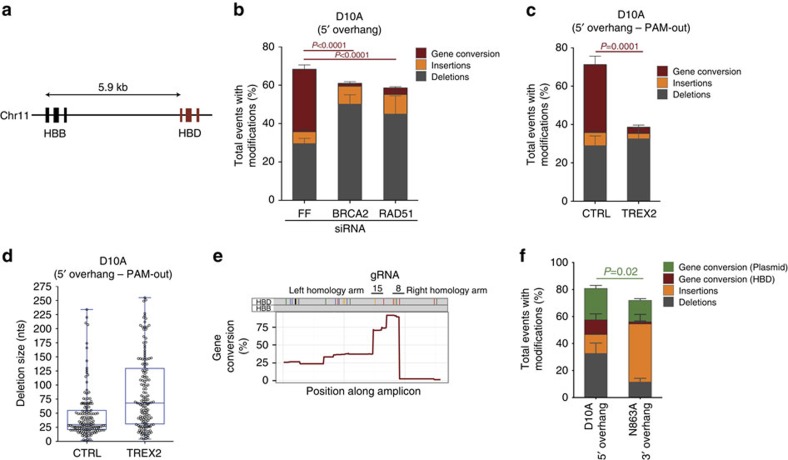
Characterization of repair outcomes of lesions introduced with the D10A Cas9 variant using gRNA pair 8/15.(a) Schematic illustration of the HBB and HBD loci on chromosome 11. (b) U2OS treated with an siRNA against firefly luciferase (control, labelled as FF), BRCA2 or RAD51 in addition to the D10A Cas9 and gRNAs 8/15. The overall modification frequency at the HBB locus resolved for deletions, insertions and gene conversion (GC) was determined by Sanger sequencing. P values (GC) were calculated using the two-tailed Student's t-test. Four independent experiments. Data are represented as mean±s.e.m. Total number of sequences analysed: 476, 407, 389 for siFF, siBRCA2 and siRAD51-treated cells. (c) The overall modification frequency resolved for deletions, insertions and GC scored by Sanger sequencing of the amplified HBB locus in U2OS cells expressing the D10A Cas9 and gRNAs 8/15 in the presence (TREX2) or absence (CTRL) of TREX2. Due to limiting amplicon size primer pairs underestimate deletion frequency. P value (GC) was calculated using the two-tailed Student's t-test. Five independent experiments. Total number of sequences: 578 for CTRL and 529 for TREX2. Data are represented as mean±s.e.m. (d) Scatter dot plot overlaid with a box and whisker plot representing the deletions size from Sanger sequences of U2SOS cells expressing D10A Cas9 with gRNAs 8/15 in the presence (TREX2) or absence (CTRL) of TREX2. Each individual dot represents one Sanger sequence with a deletion. Due to limiting amplicon size primer pairs underestimate deletion frequency. The line within the box depicts the median, with the box extending from the 25th to the 75th percentiles. The whiskers depict the minimum and maximum values of the data set. Five independent experiments, total number of sequences: 147 for CTRL and 149 for TREX2. (e) Graph showing positions of nucleotide mismatches (colours) and deletions (black) between the HBD and the HBB genes as coloured rods (top). Histogram of relative GC frequency plotted as a function of the position on the HBB locus (bottom). (f) Overall modification frequency at the HBB locus separated into deletions, insertions and GC from either the endogenous HBD gene or a plasmid source. The different repair outcomes after D10A or N863A Cas9 activity in U2OS cells followed by Sanger sequencing of individual HBB amplification products. Four independent experiments. Data are represented as mean±s.e.m. P value (Gene conversion (plasmid)) was calculated using the two-tailed Student's t-test. Total number of sequences analysed: 199 and 304 for D10A Cas9 and N863A Cas9.